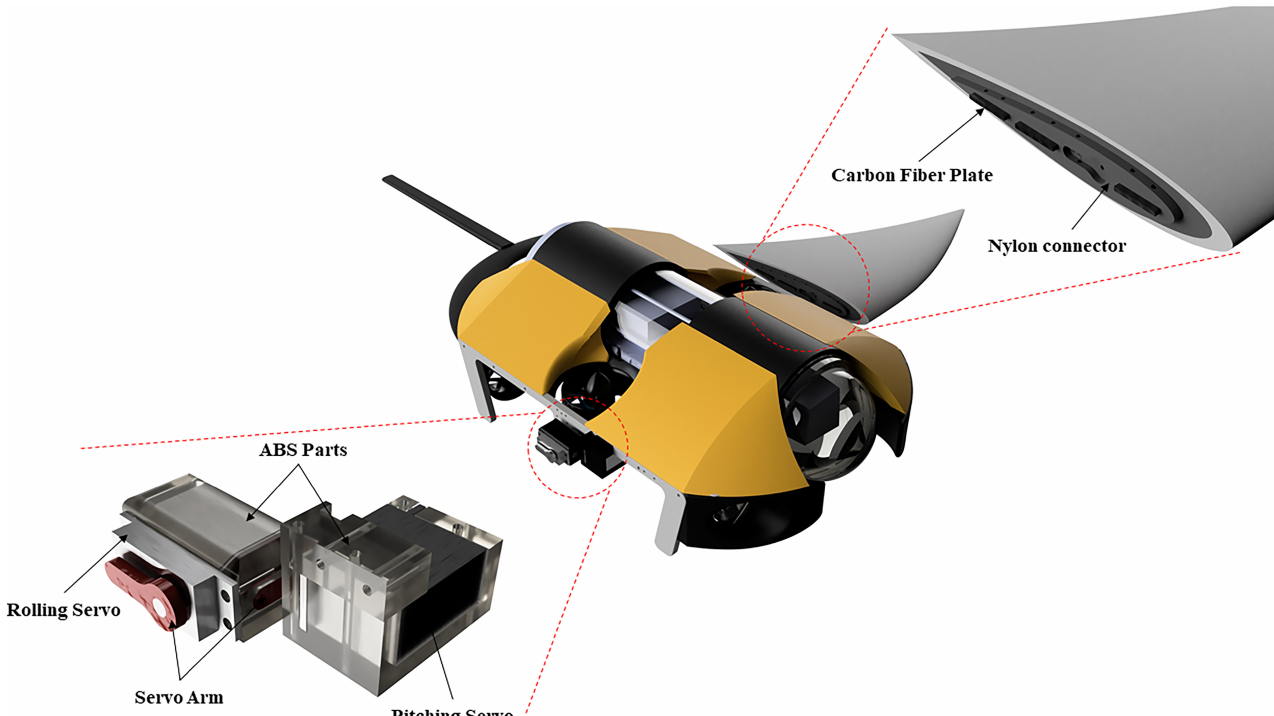
Figure 4. The connection between the flapping wing and the main